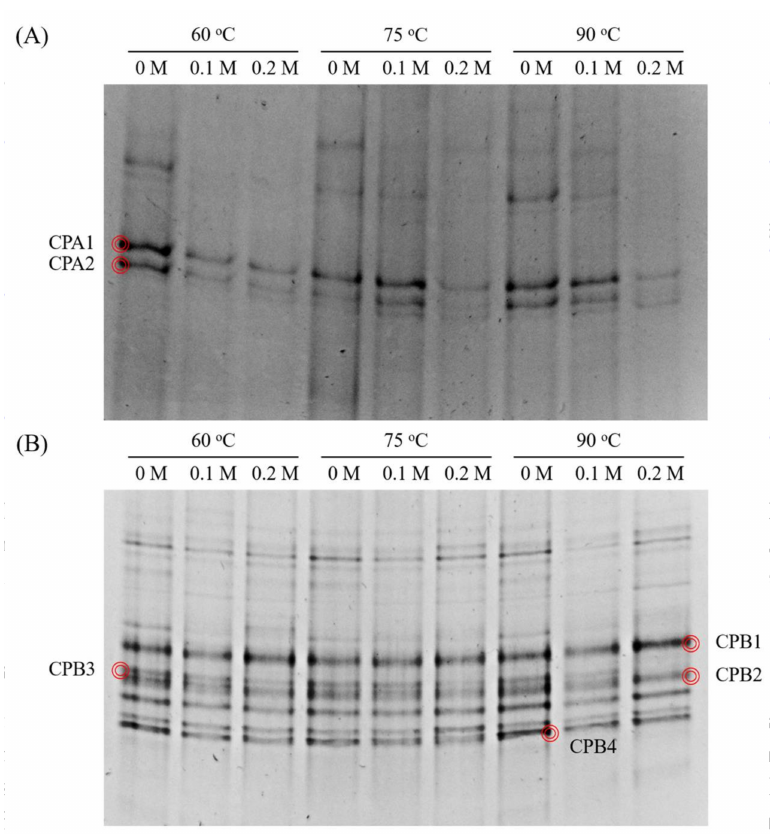
Figure 5. DGGE profiles of archaeal ( A ) and bacterial ( B ) 16S rRNA gene PCR fragments from the BMP runs with pretreated SCG. Each lane is labeled with the corresponding pretreatment conditions, i.e., NaOH concentration (M) and temperature ( ◦